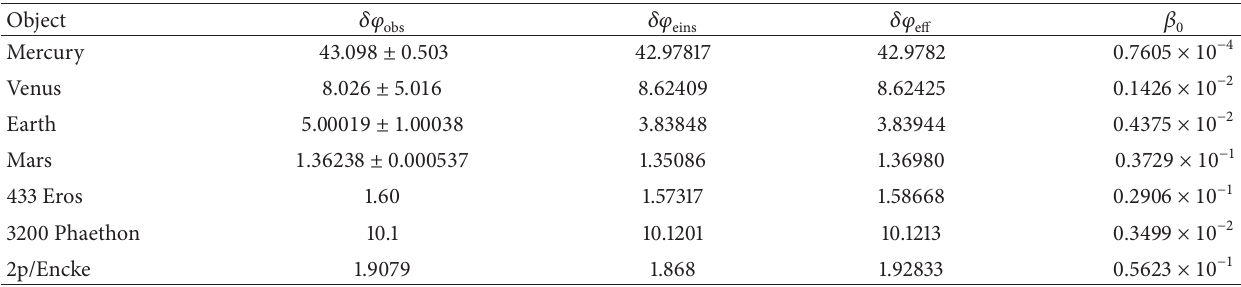
Table 1: Comparison between the values of secular precession of inner planets in units of arcsec/century ( 󸀠󸀠 ⋅ cy −1 ) of the standard (Einstein) perihelionprecession 𝛿𝜑 eins [22]forneutraltestparticles(planets,asteroids/comets)intheconformastaticmagnetizedspacetimeofapunctual mass 𝛿𝜙 eff . The data for 𝛿𝜑 obs stands for the secular observed perihelion precession in units of arcsec/century adapted from [23] by adding a supplementary precession correction from EPM2011 [19, 20]. In addition, the results for the NEOS 433 Eros, 3200 Phaethon, and 2p/Encke comet are also presented. The mass of the 2p/Encle comet as 𝑚 = 3.85 × 10 13 kg was estimated with a bulk density 𝜌 = 0.5 g ⋅ cm 3 as shown in